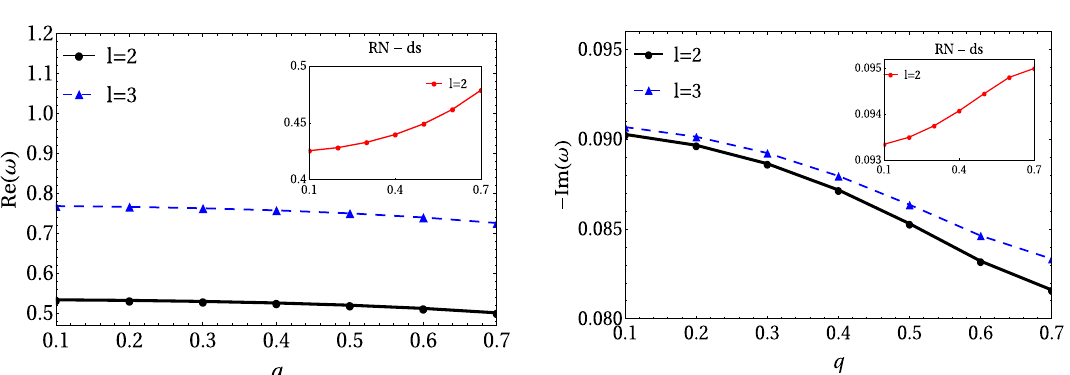
for the parameter (cid:2) = 0 . 007 and q = 0 . 57. As it is